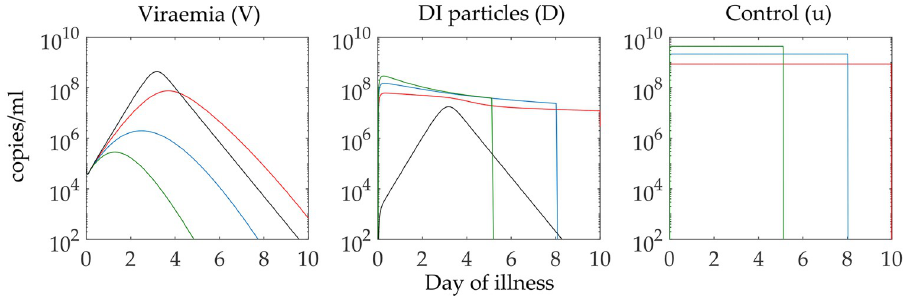
Fig 7. Optimisation of the dose treatment. A very high dose of DI particles treatment can reduce the viraemia peak and clears the viral load within fewer days, but it may not lead to optimal control treatment in terms of the objective function and the expense of the control. For an arbitrary model from the sets of POMs, we observe the effect of different doses (control upper bound) of DI particles addition and solving for the switching time point. The black lines are the trajectories of uncontrolled viraemia and DI particles. The coloured lines are the controlled trajectories of the viraemia and DI particles and the control profiles with different control upper bounds of 1.0 × 10 9 (red), 2.0 × 10 9 (blue), and 4.0 × 10 9 (green) copies of DI particles. We have estimated the efficiency of the control treatment in terms of viraemia reduction